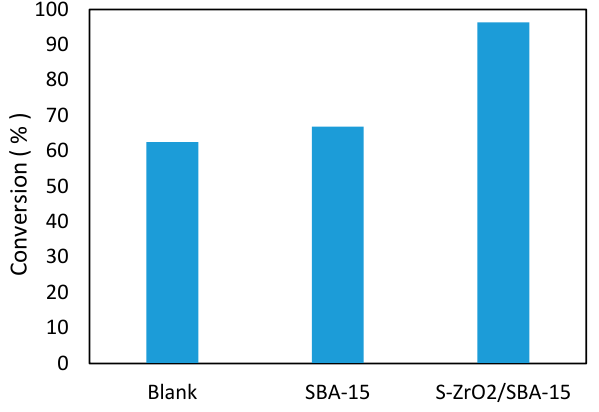
Figure 7. Comparison of the non-catalytic and catalytic processes on biodiesel content at optimum conditions.